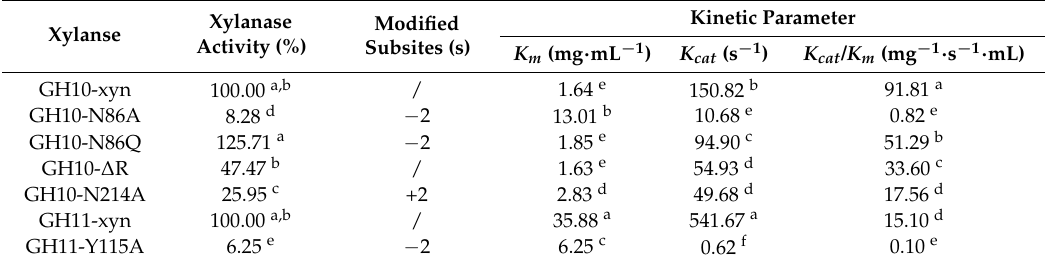
Means with the same superscript letter are not significantly different ( p <